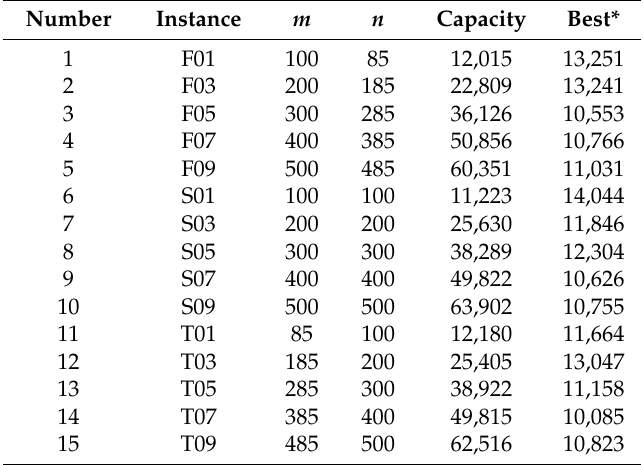
Table 3. The parameters and the best solution value provided in [5] for 15 SUKP